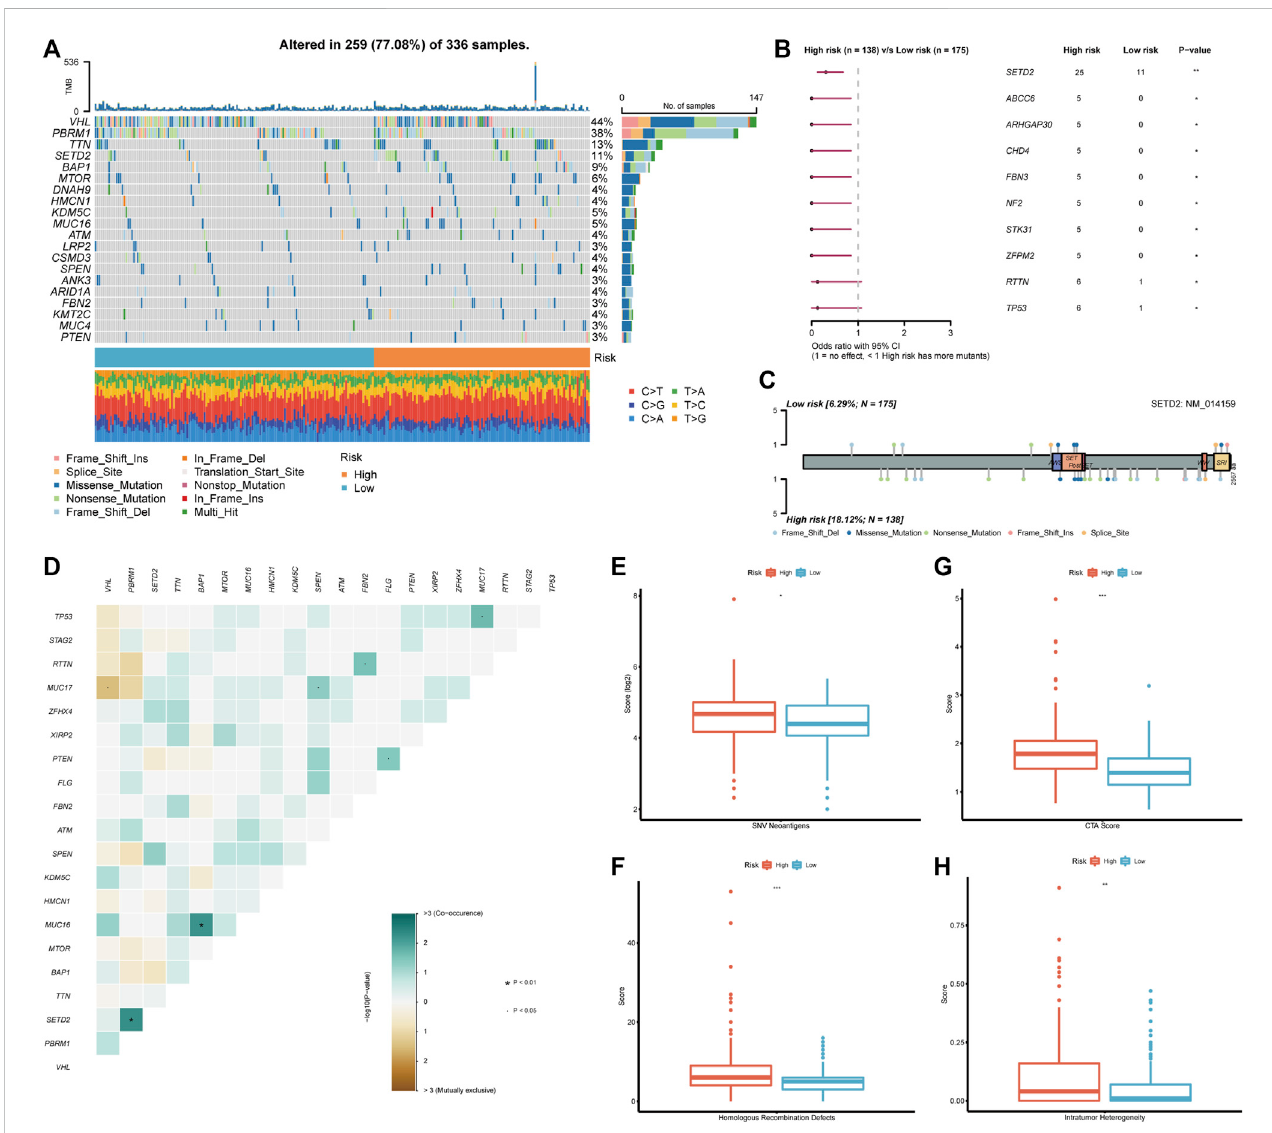
FIGURE 6 Genomic analysis in accordance with the BMRS risk groups. (A) The waterfall plot representing the top 20 mutated genes in both risk groups. (B) The mutants that signi fi cantly differentiated between high and low risk groups. (C) Exhibition of the mutation sites and types of SETD2 in both risk groups. (D) The correlation of the mutants in the high risk group. (E – H) Comparison of SNV neoantigens, HRD, CTA score, and ITH between high and low risk